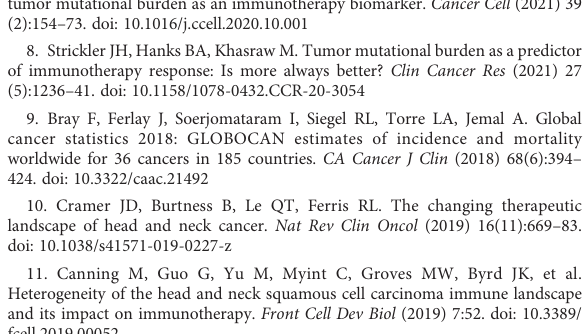
SUPPLEMENTAL TABLE 7 Differential gene expression between cells with Responder top TCR clonotypes and cells with Non-responder top TCR clonotypes. SUPPLEMENTAL TABLE 8 Flow Cytometry Antibodies used in the